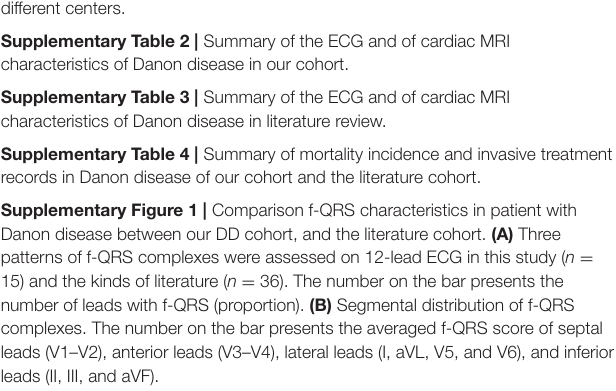
Supplementary Table 1 | Summary of CMR acquisition protocol details from different centers. Supplementary Table 2 | Summary of the ECG and of cardiac MRI characteristics of Danon disease in our cohort. Supplementary Table 3 | Summary of the ECG and of cardiac MRI characteristics of Danon disease in literature review. Supplementary Table 4 | Summary of mortality incidence and invasive treatment records in Danon disease of our cohort and the literature cohort. Supplementary Figure 1 | Comparison f-QRS characteristics in patient with Danon disease between our DD cohort, and the literature cohort. (A) Three patterns of f-QRS complexes were assessed on 12-lead ECG in this study ( n = 15) and the kinds of literature ( n = 36). The number on the bar presents the number of leads with f-QRS (proportion). (B) Segmental distribution of f-QRS complexes. The number on the bar presents the averaged f-QRS score of